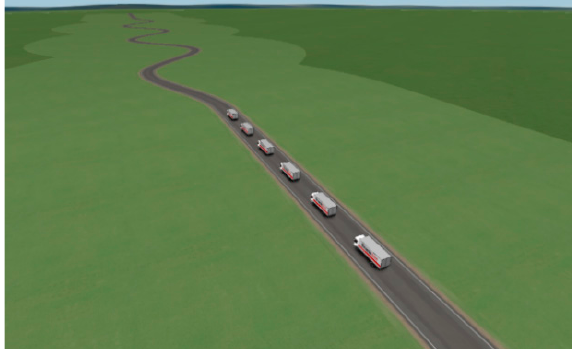
Figure 4. Coordinate system conversion diagram.